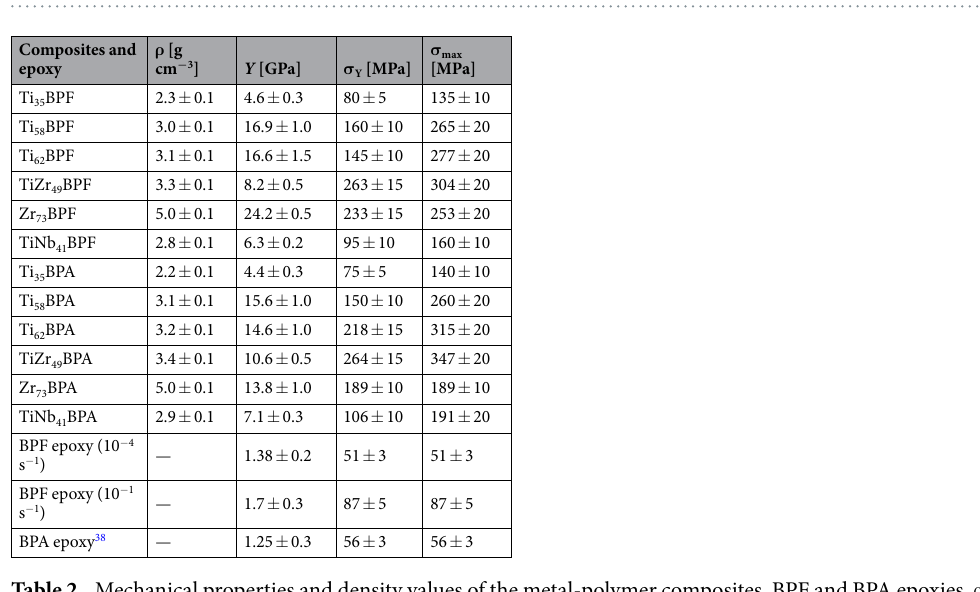
Table 2. Mechanical properties and density values of the metal-polymer composites, BPF and BPA epoxies. ρ - mass density, Y – Young’s modulus, σ Y – yield strength and σ max – maximum